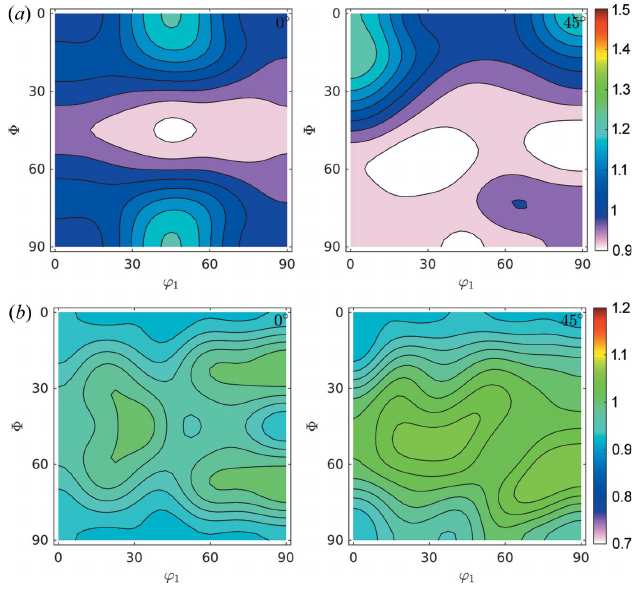
Figure 13 GDFs for ( a ) domain size and ( b ) dislocation density at ’ 2 = 0 (cid:6) and ’ 2 = 45 (cid:6) . Heat-treated sample, 5 s at 600 (cid:6) C.